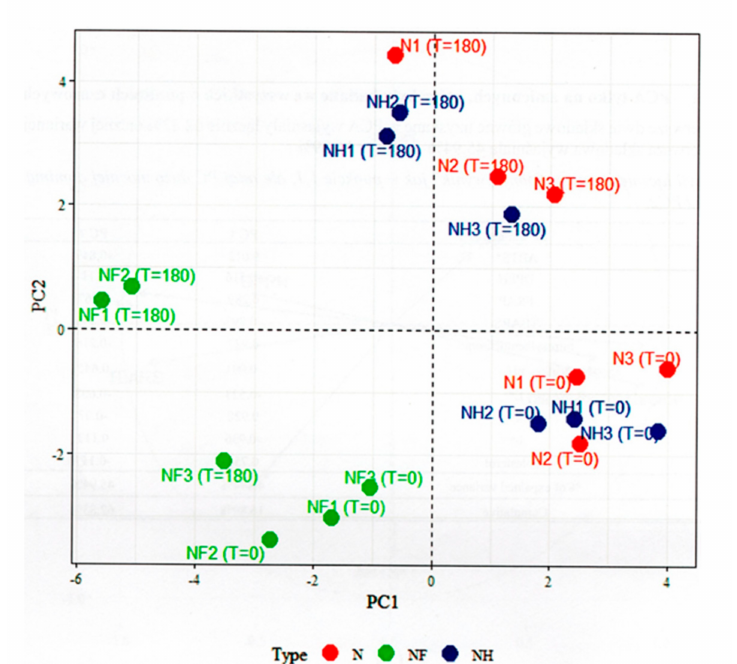
Figure 3. The individuals factor map